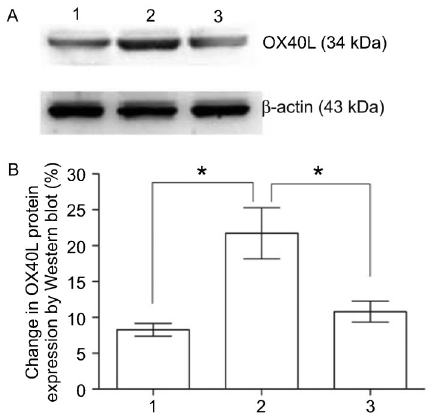
Figure 4. A , OX40L expression levels in HUVECs treated with 1) no Ox-LDL (untreated control); 2) 100 m g/mL Ox-LDL, and 3) 250 m g/ m L Poly I plus 100 m g/mL Ox-LDL. B , The expression of OX40L in group 2 was increased compared with group 1, while OX40L protein expression in group 3 was decreased compared with group 2 (n=4; *P , 0.05, t -test). HUVECs: human umbilical vein endothelial cells; Ox-LDL: oxidative low-density lipoprotein; Poly I: polyinosinic